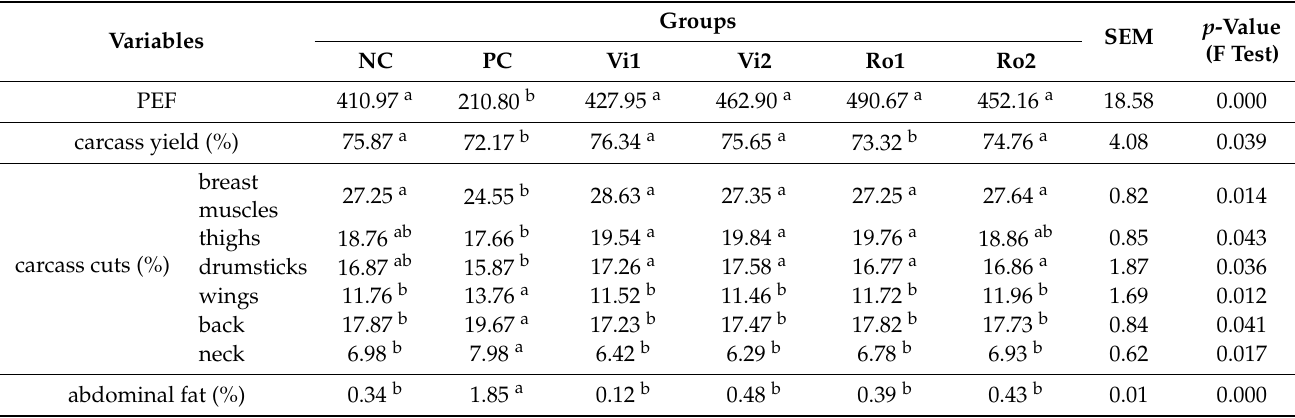
Table 5. PEF, carcass yield, and abdominal fat (%) of broiler chickens affected by dietary vinegar and rocket salad of stressed broiler chickens ( n = 16/treatment).